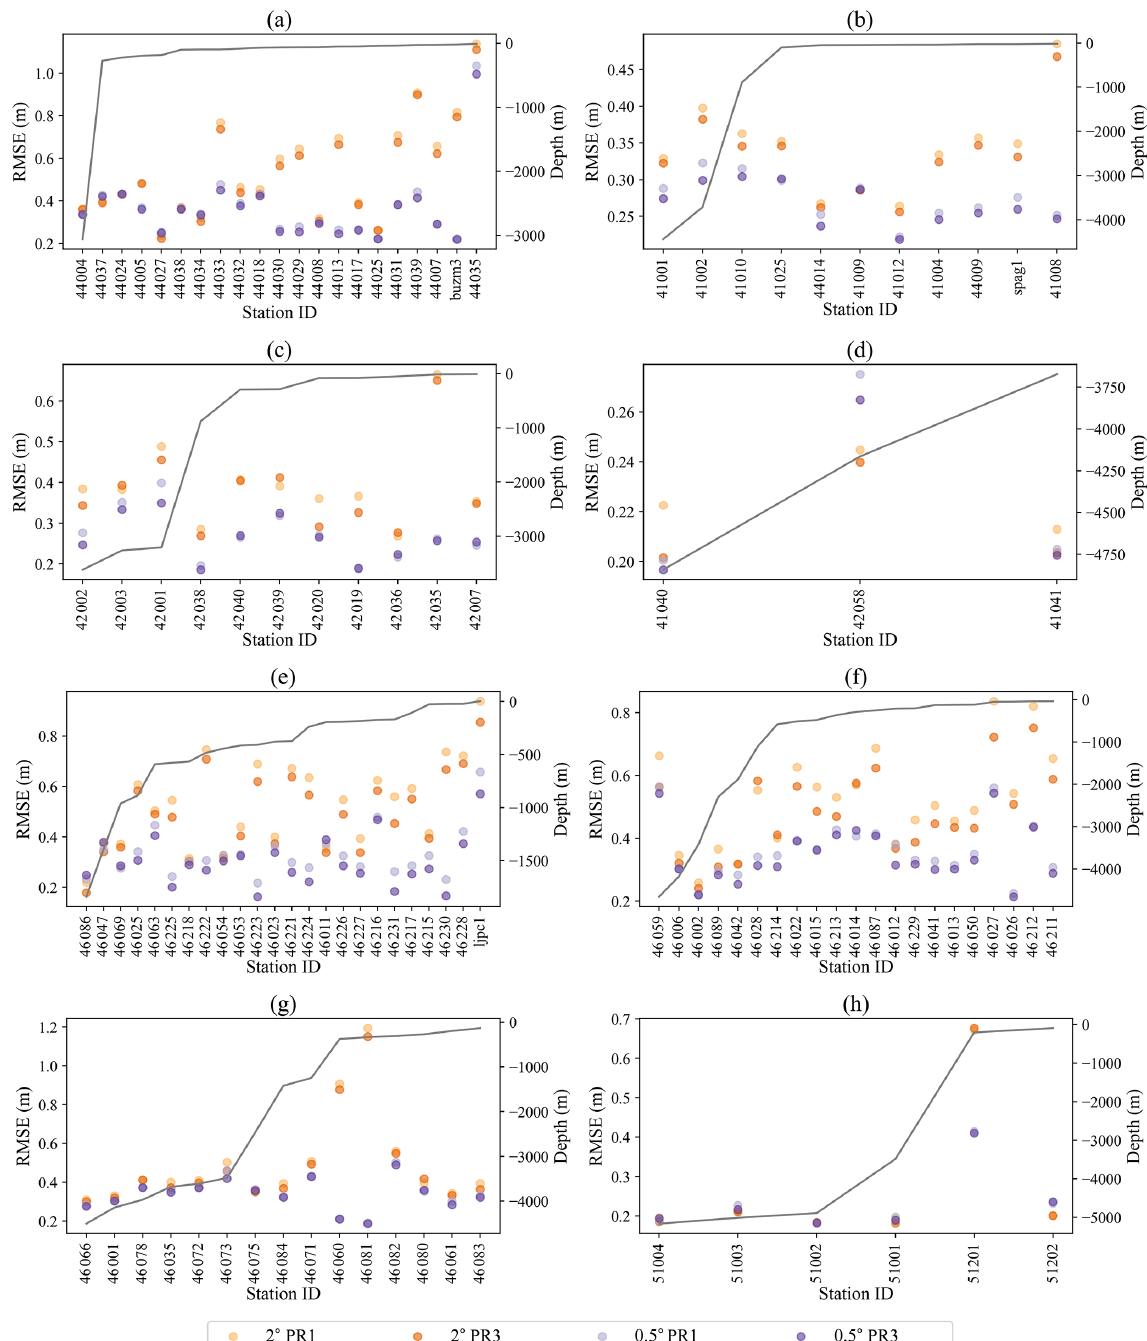
Figure A1. Root mean square errors comparing the accuracy differences between the PR1 and PR3 + UQ switches. The 2 ◦ structured mesh is represented by orange and the 0.5 ◦ structured mesh is shown in purple. Darker shades are associated with the PR3 configuration, while lighter shades correspond to the PR1 switch. Subplots are presented in order of regions from the paper as follows: (a) Gulf of Maine, (b) southern to mid-Atlantic east coast, (c) Gulf of Mexico, (d) Caribbean region, (e) Southern California coast, (f) Northern California and Pacific Northwest coast, (g) Alaskan coast, and (h) Hawaiian